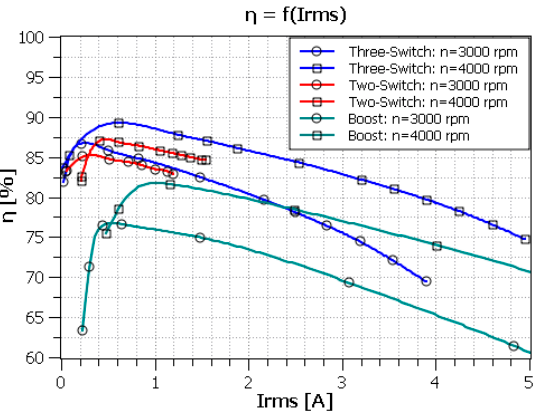
Figure 9. Converter efficiency as a function of the generator rms phase current value.